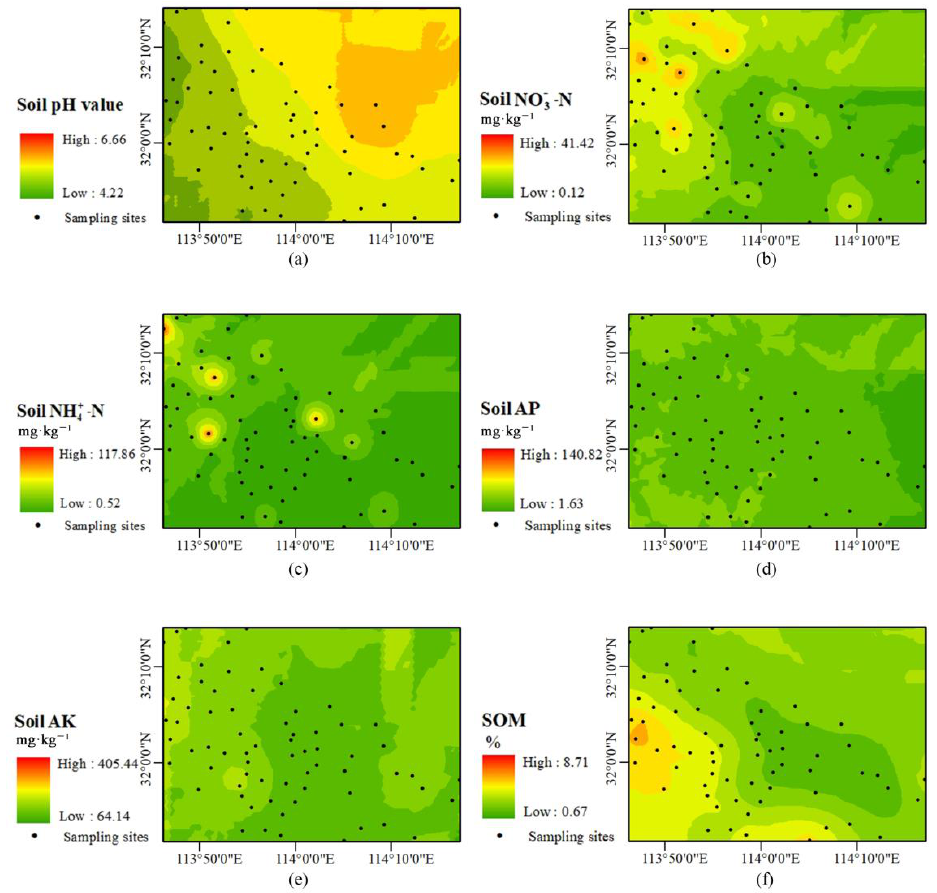
Figure 2. Distribution of soil pH and soil nutrients. ( a ) Distribution of soil pH. ( b ) Distribution of soil NO - -N. ( c ) Distribution of soil 3 NH + -N. ( d ) Distribution of soil AP. ( e ) Distribution of soil AK. ( f ) Distribution of soil SOM. The distribution of soil pH and soil nutrient concentrations are presented in Figure 2. The soil pH values increased from the southwest to the northeast of the study area. The distributions of soil NO - -N and NH + -N showed a similar spatial distribution pattern, 3 4